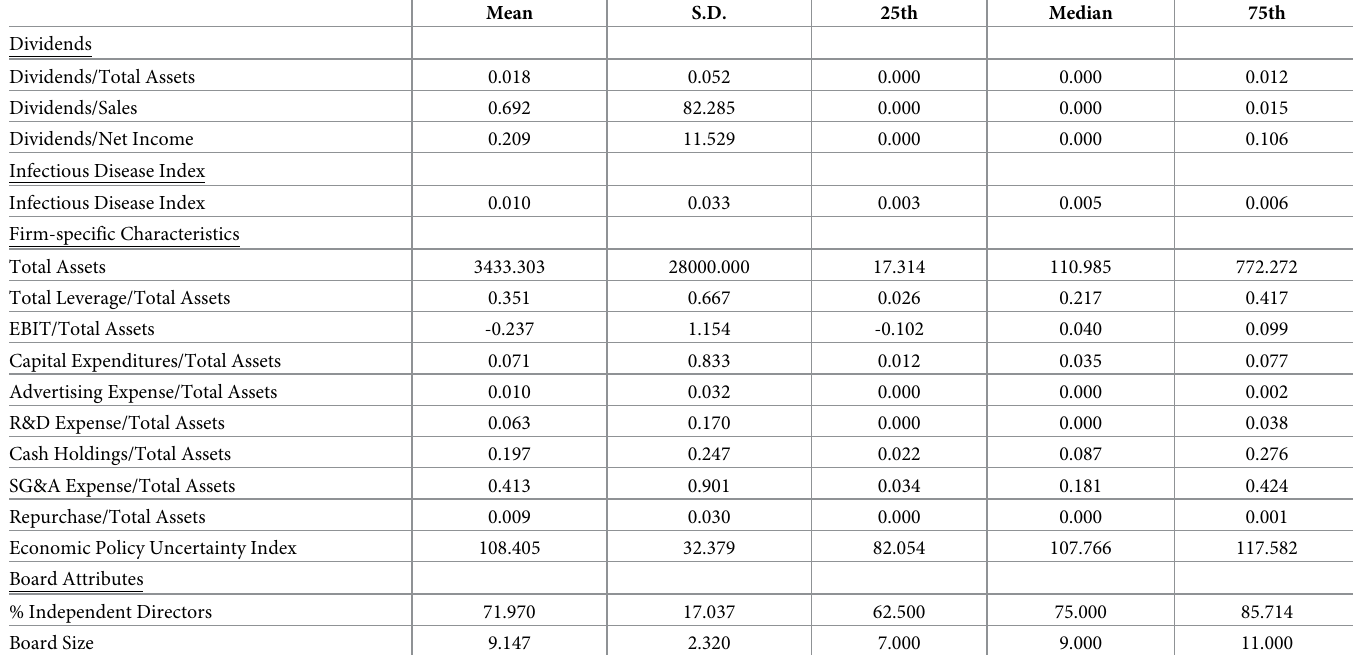
Table 1. Descriptive statistics. Our measure of disease-related uncertainty is the infectious disease equity market volatility developed by Baker et al. (2020) [9]. Using sophisticated textual analysis, Baker et al. (2020) [9] search for news articles related to infectious diseases and equity market volatility. A higher fraction of these news arti- cles to all articles in each time period signifies a higher level of market uncertainty that can be ascribed to infectious diseases. For ease of interpretation, we have the infec- tious disease equity market volatility index divided by